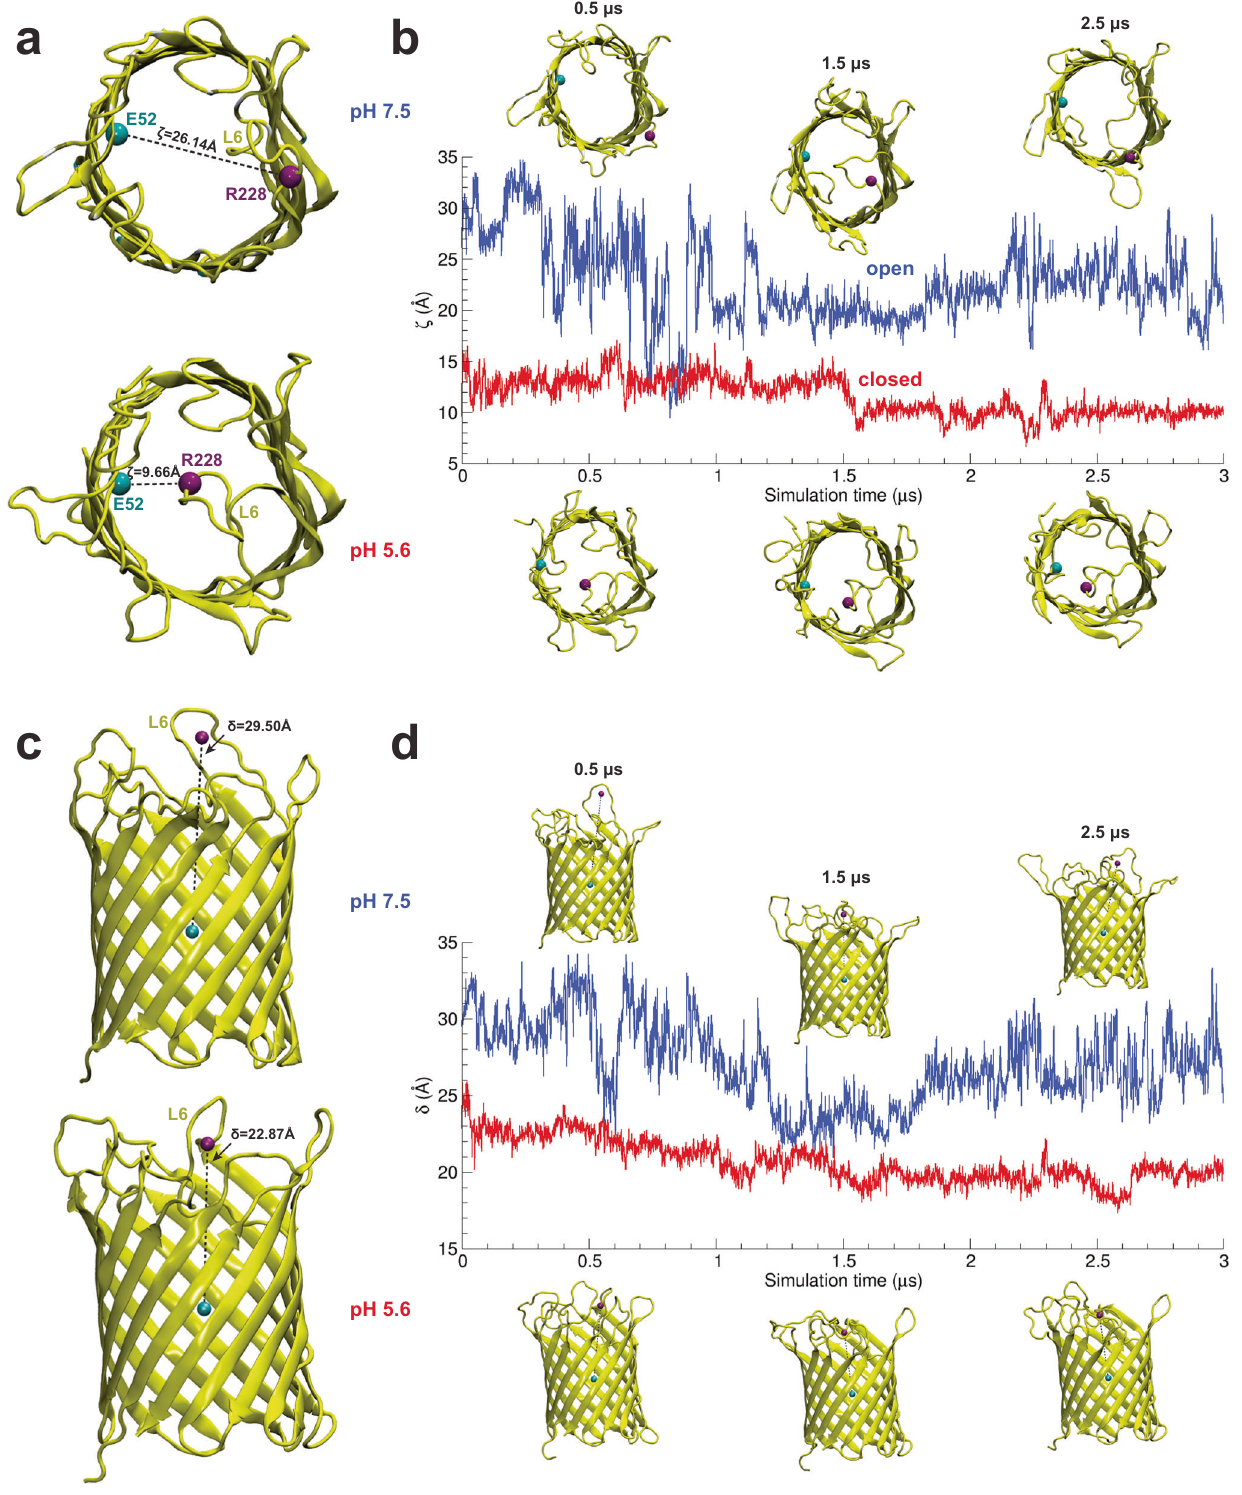
Fig. 3 pH-dependent gating analysis of OmpG using molecular dynamics simulations. a Collective variable ζ is the distance between the C α atoms of residues E52 (cyan spheres) and R228 (purple spheres). ζ in the open and closed state crystal structures are 26.1 Å and 9.6 Å, respectively. b Time series of ζ for the open and closed states of OmpG. Representative structures in the open (top) and closed (bottom) states from simulations at 0.5, 1.5, and 2.5 µ s are shown (Supplementary Movie 2, 3). c collective variable δ between the centers of mass (COM) of the backbone atoms for the barrel (cyan balls) and the C α atoms for residues 220 – 228 of loop-6 (purple spheres). Corresponding δ values in X-ray structures of OmpG in the open and closed states are indicated. d Time series of the δ for the open and closed states of OmpG. Representative structures of OmpG in the open (top) and closed (bottom) states at 0.5, 1.5, and 2.5 µ s are shown (Supplementary Movie 4,